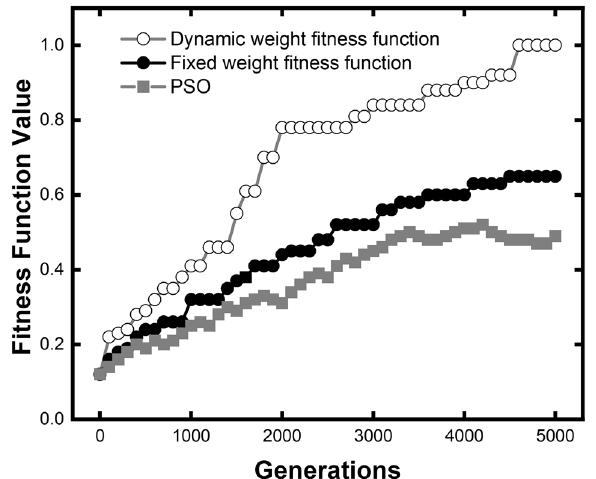
Figure 3. Comparison of comprehensive optimization efficiency between dynamic algorithm for fitness function and fixed weight fitness function. Dynamic algorithm has an advantage in overall optimization efficiency at the early stage of GA process.